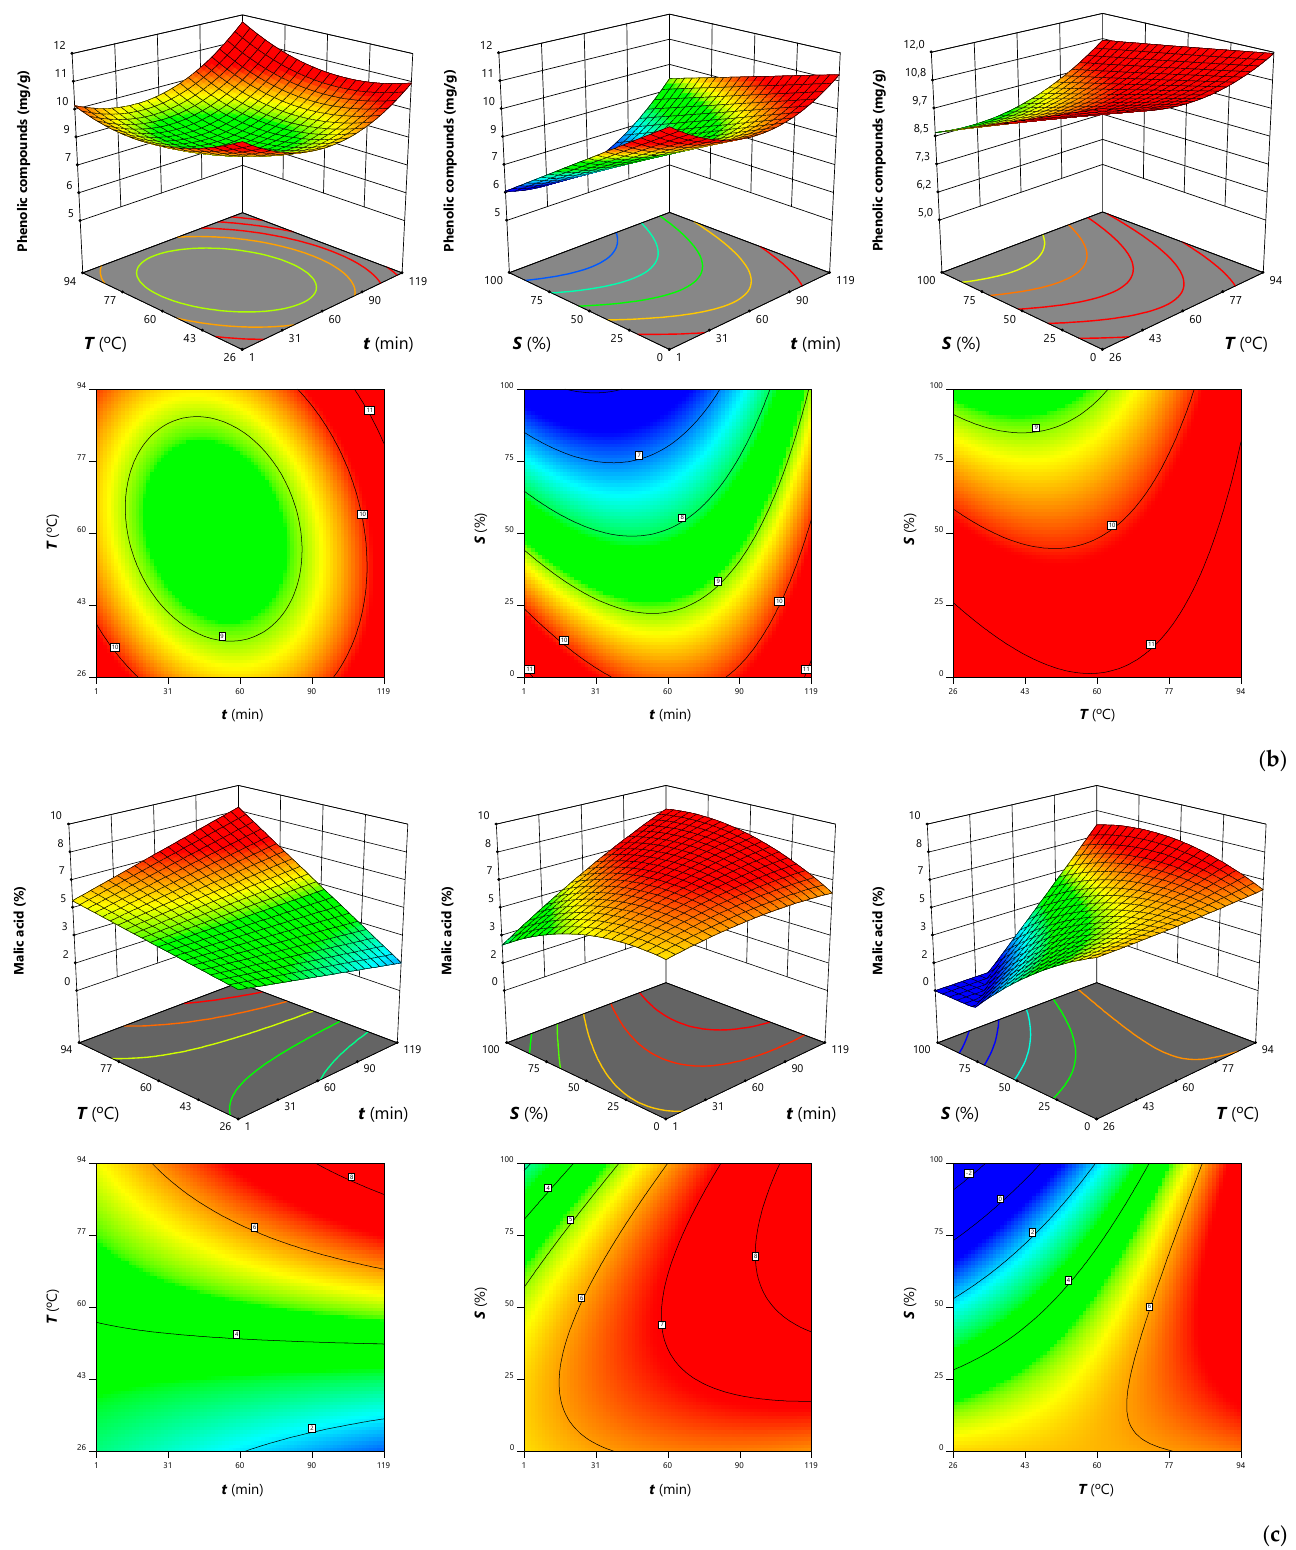
Figure 3. Response plots illustrating the effects of the independent variables on BE yield ( a ), phenolic compounds, ( b ) and malic acid ( c ) obtained from quince peel. In each plot, the unplotted independent variable was kept constant at its optimum shown in Table S5.